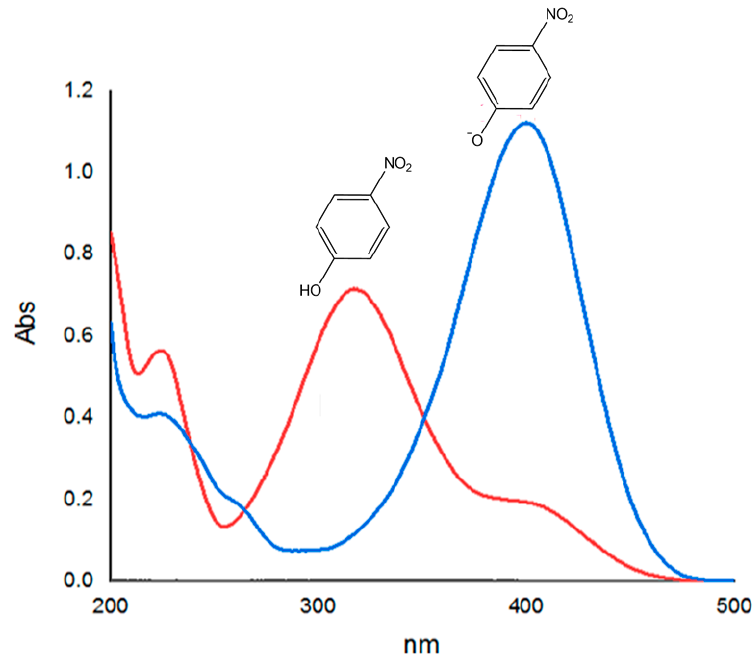
Figure 1. Monitoring the progress of reaction using UV-Vis spectroscopy.